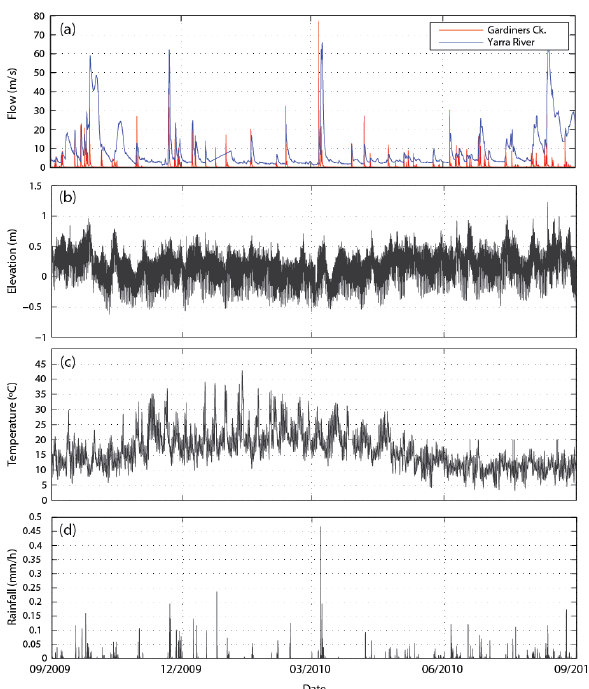
Fig. 3. Yarra River estuary model boundary condition data: (a) in- flows, (b) surface water elevation at Spencer Street Bridge, (c) air temperature, and (d) rainfall.